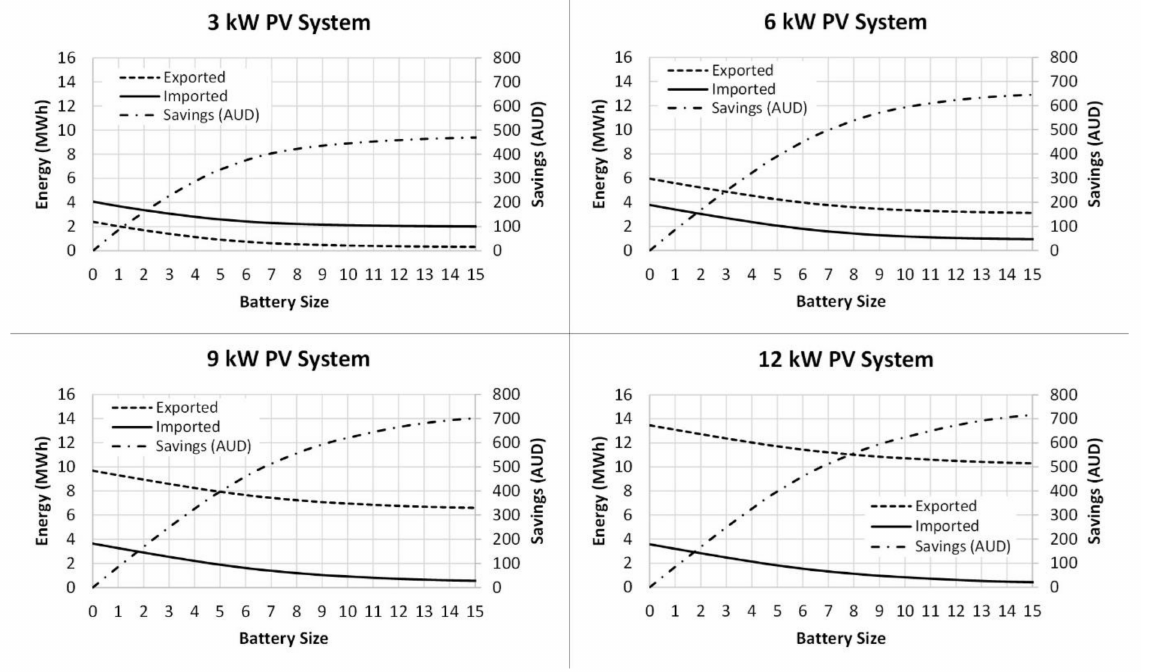
Figure 8. House 2: Energy flows and cost savings as a function of battery